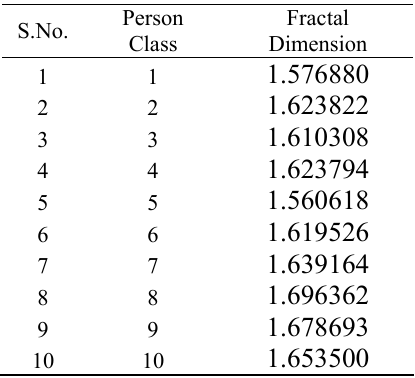
Table 2. Fractal dimensions of a selected face images in AT &T face database.